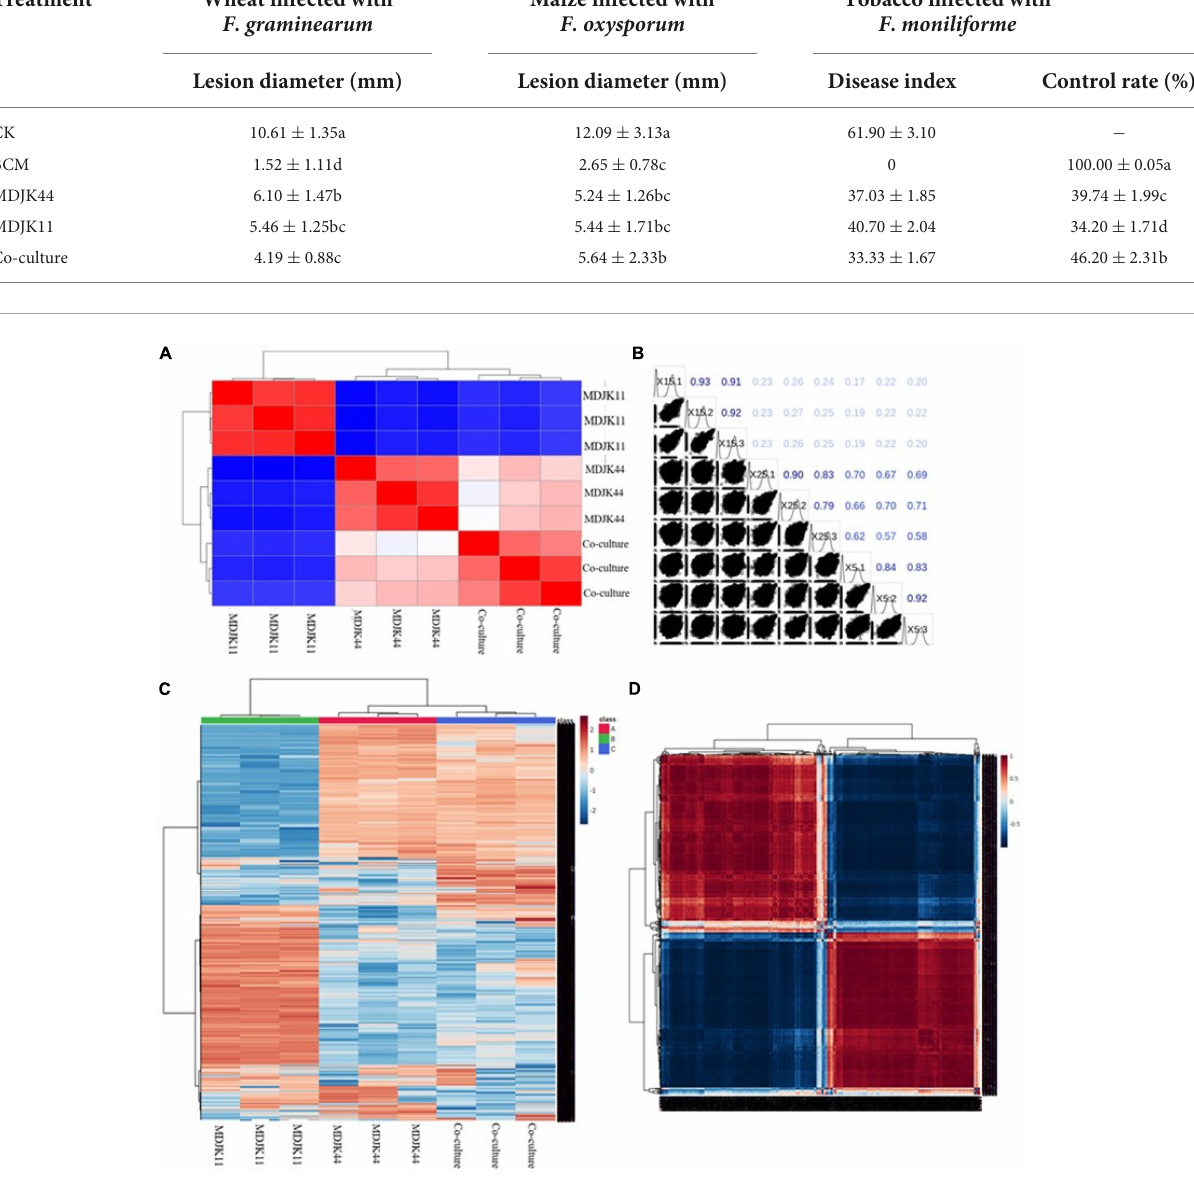
FIGURE7 Metabonomic analysis of Streptomyces MDJK44, MDJK11 monoculture, and co-culture in BF4 medium [ (A) , correlation plot; (B) , correlation matrix plot; (C) , cluster analysis plot; and (D) , correlation heat map].